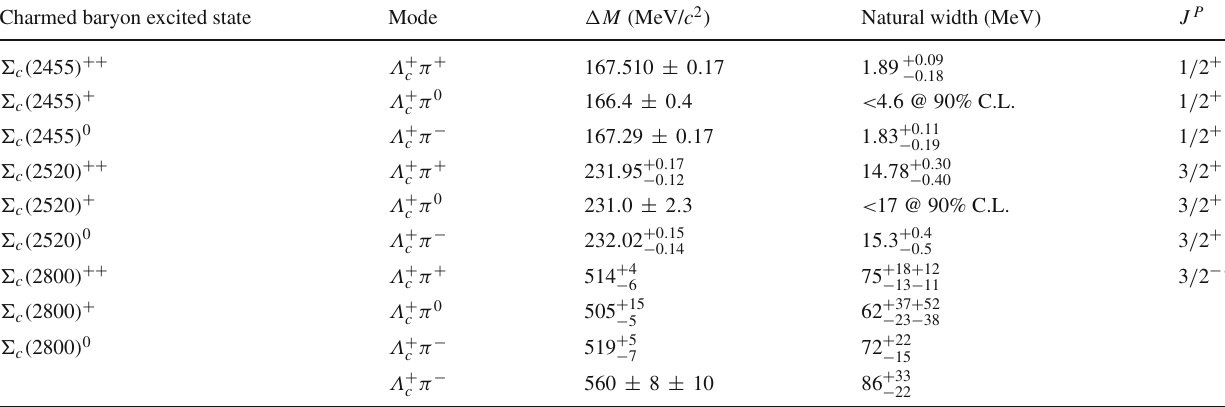
Table 298 Summary of the excited (cid:29) ++ , + , 0 c